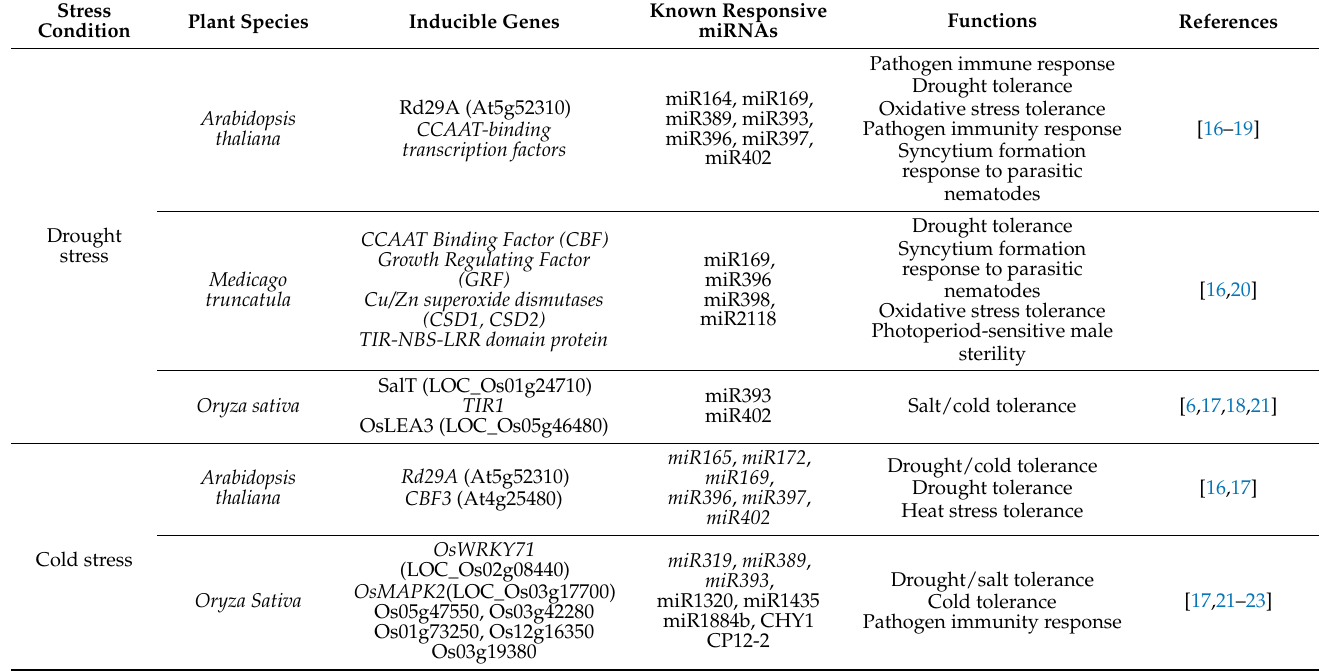
Table 1. Examples of miRNAs identified in model plants under drought, cold and salinity